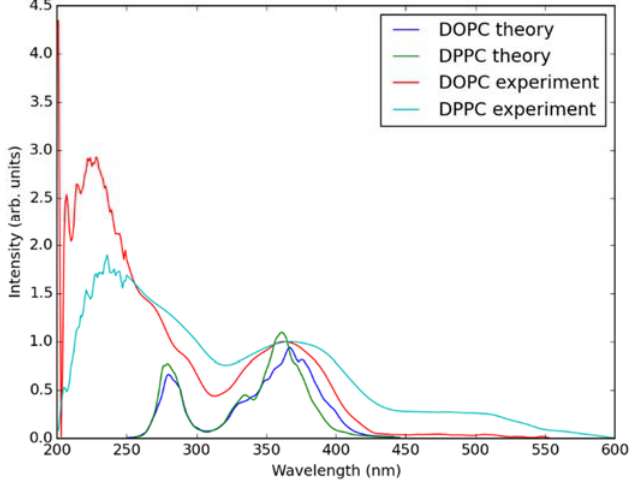
Figure 5. Simulated (using QM/MM MD approach) and experimentally measured absorption spectra of Laurdan in DOPC and DPPC bilayers.